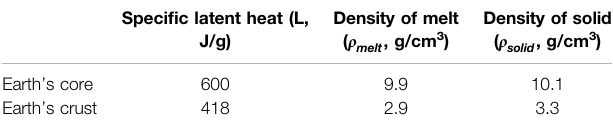
TABLE 1 | Values of the speci fi c latent heat and densities of the melt and solid solidi fi ed at the shallow Earth is 2.7 × 10 15 kg yr − 1 , which corresponds used for latent heat analysis (Ohtani and Maeda, 2001; Suzuki and Ohtani, to a volume change of − 120 km 3 yr − 1 and a radius change of 2003; Massonne et al., 2007; Sakamaki et al., 2009; Zhang et al., 2014; Zhang − 0 . 24 mm yr − 1 . Overall, the heat fl ow of the Earth is in et al., 2020). agreement with a shrinkage of − 120.24 km 3 yr − 1 in the Earth ’ s Speci fi c latent heat (L, Density of melt Density of solid J/g) ( ρ melt , g/cm 3 ) ( ρ solid , g/cm 3